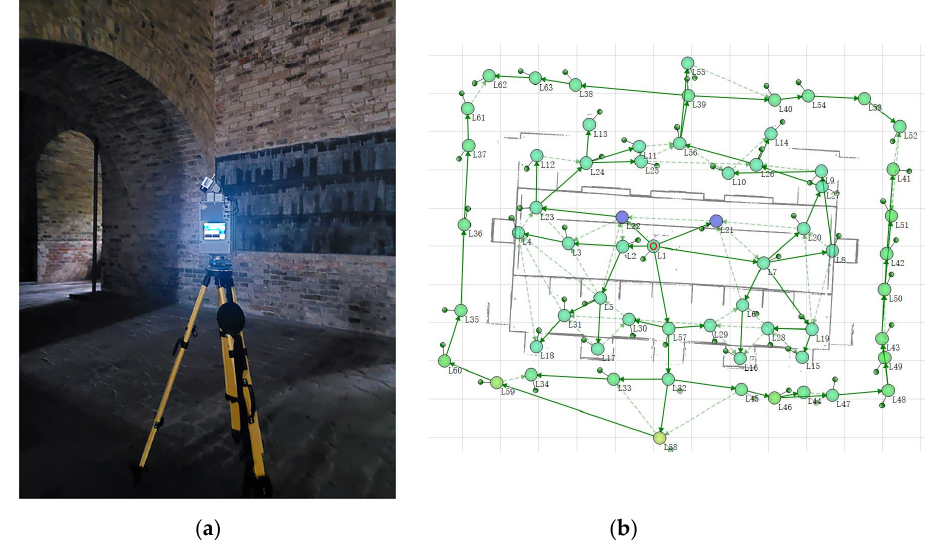
Figure 2. Terrestrial laser-scanner-based survey for the Beamless Hall. ( a ) Field survey with a Z + F Imager 5010X laser scanner. ( b ) Spatial distribution of 63 scan stations.